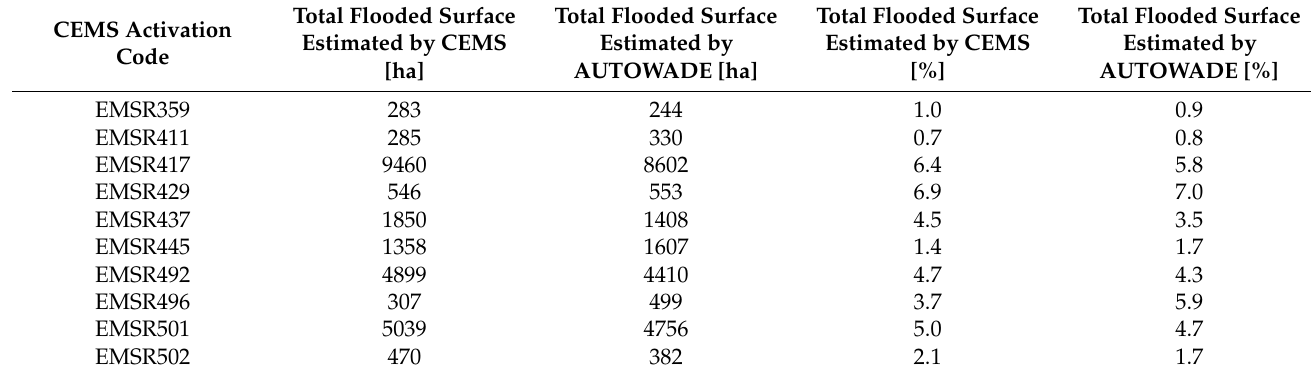
Table 8. Comparison between CEMS-derived and AUTOWADE-derived open floodwater maps in terms of extent of the flooded area in ha and in percentage with respect to the size of the AOI (6th column of Table 2). CEMS Activation Code